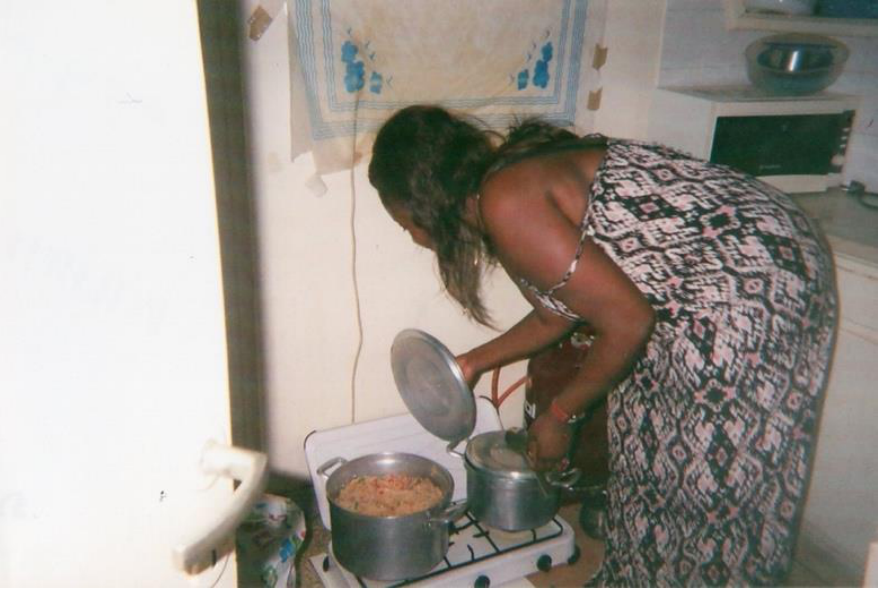
Figure 1: Making dinner (photo: visual diaries